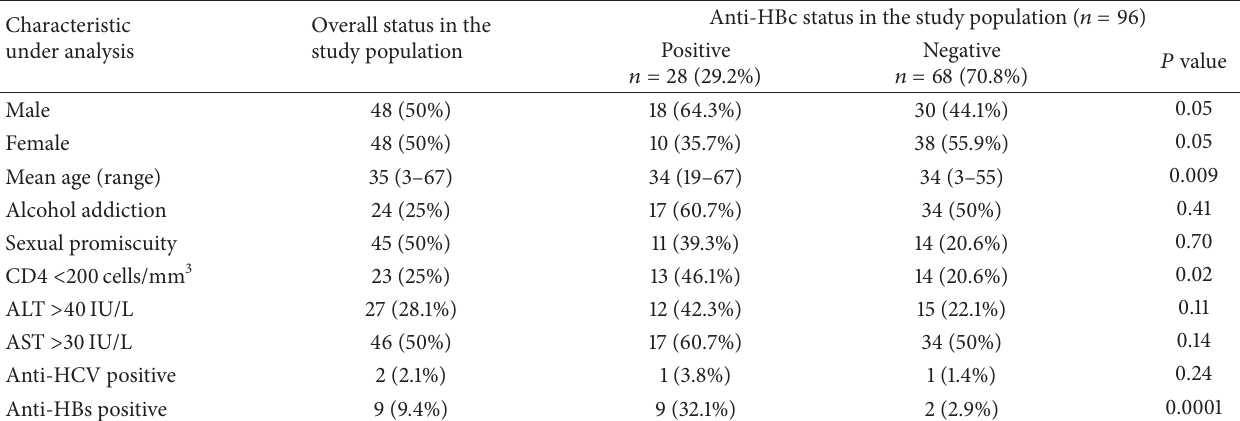
Table 1: Evaluation of overall demographic, biochemical, and virological parameters of the study populations. 𝑃 values by 𝑡 -test.